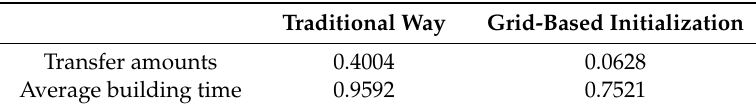
Table 1. The relevancy of grid-based